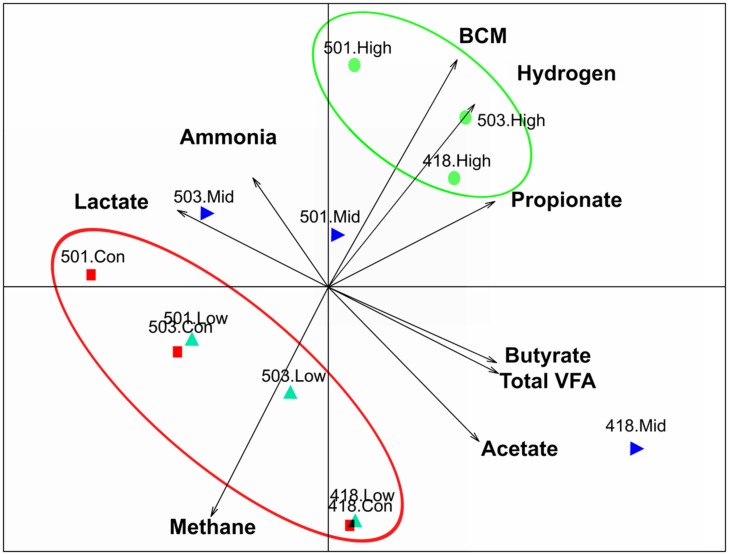
Principal coordinate analysis co-inertia plot coupling rumen microbiome Euclidean analysis and biochemical measures, with arrows indicating increasing values of biochemical measures. Rumen microbiomes for animals on varying levels of BCM for control (red square), low dose (turquoise triangle), mid dose (blue right triangle), high dose (green circle), labels indicate animal number and treatment.